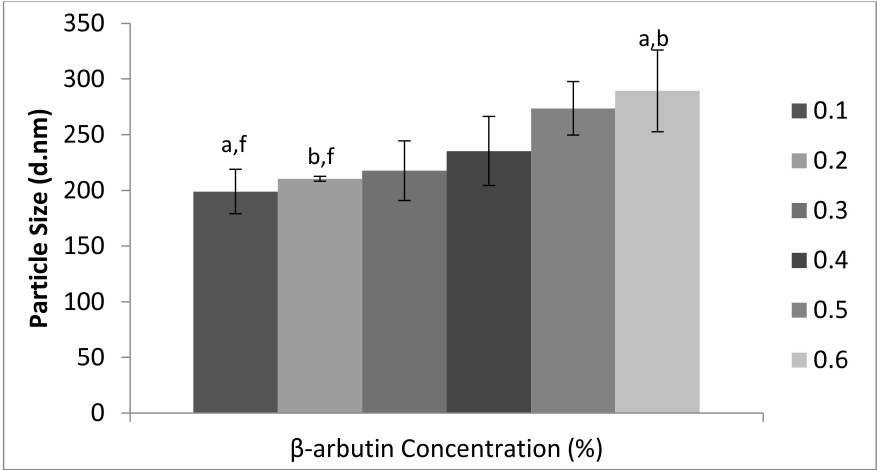
Figure 1. Particle size of 0.1%, 0.2%, 0.3%, 0.4%, 0.5%, and 0.6% β -arbutin CSNPs. ( n = 3). Different alphabets show significance difference, p < 0.05.